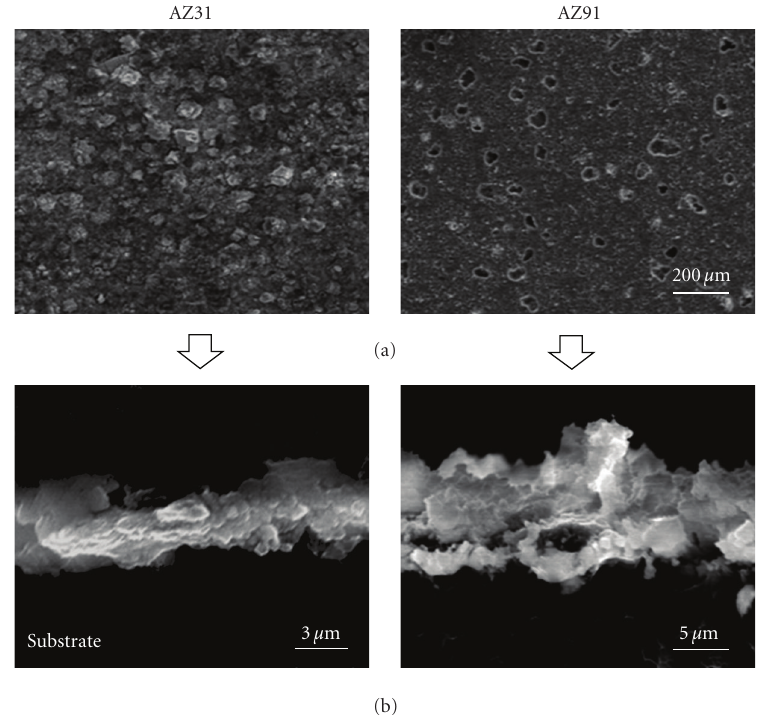
Figure 8: Surface and cross section images of AZ31 and AZ91 magnesium alloys after anodizing in 1MNaOH solution at 3V for 30 minutes.